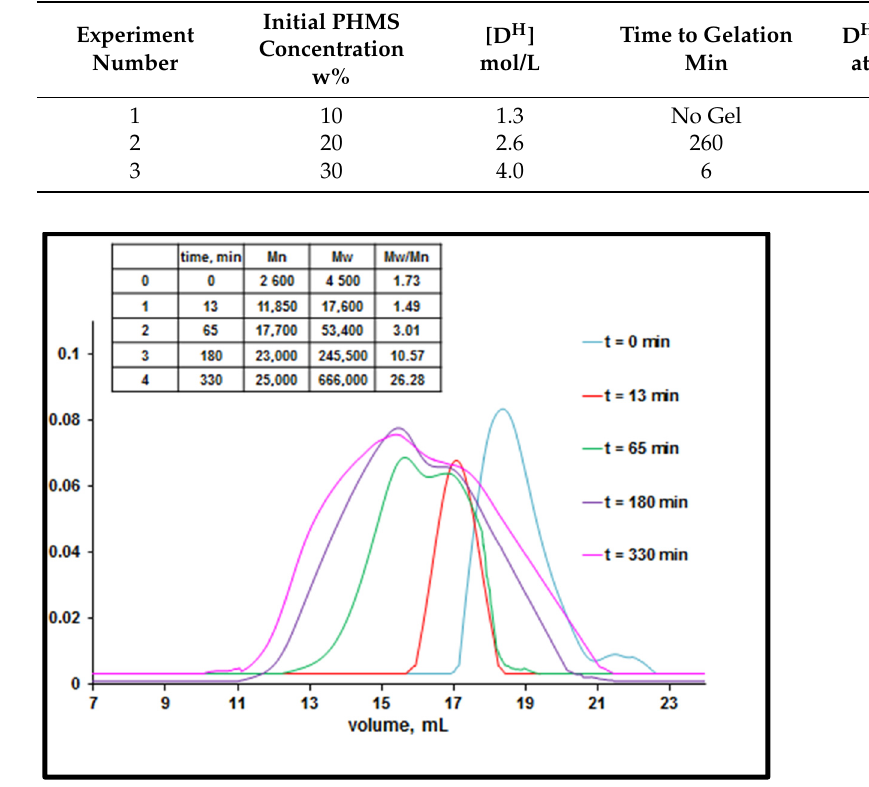
Figure 6. The variation in the molar mass distribution of the PHMS polymer during the restruc- turing in 20 wt% toluene solution at 30 °C in the presence of 1 × 10 − 2 mol/L TPFPB.